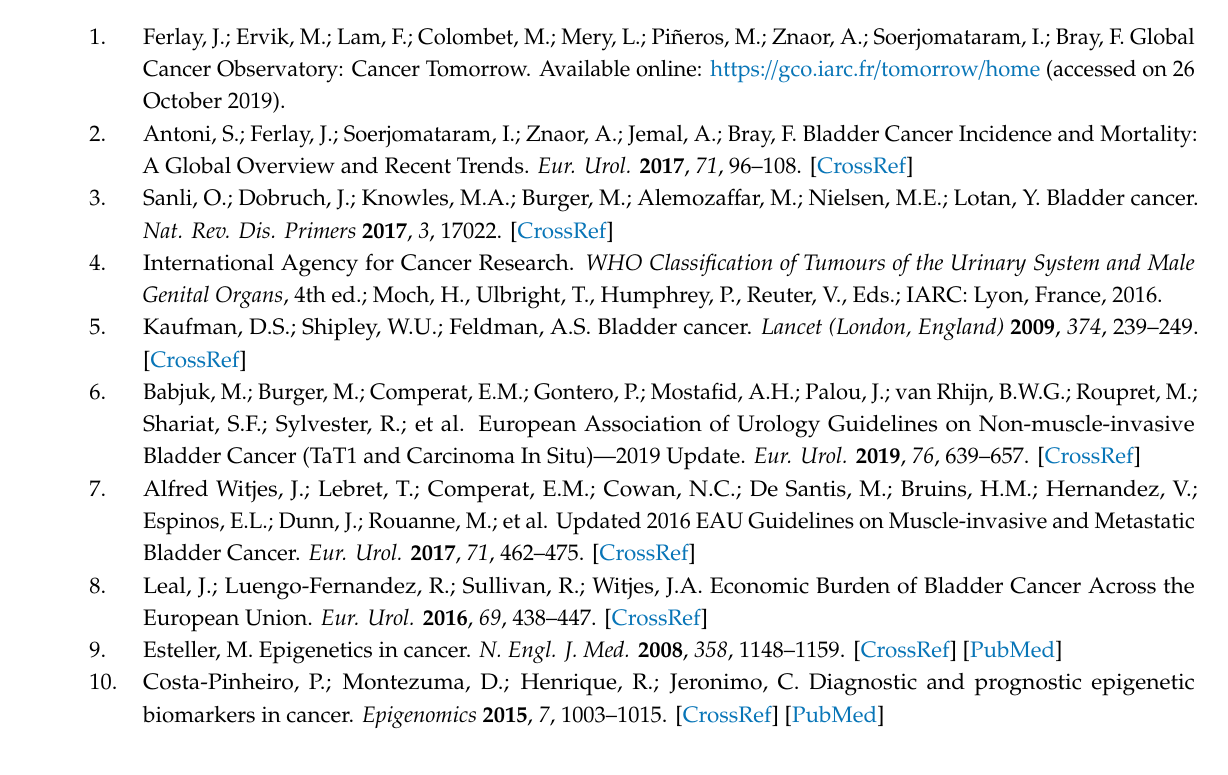
Figure S1: Distribution of miR663a me and VIM me levels in bladder carcinoma tissue samples categorised by grade; Figure S2: Kaplan-Meyer curves representing disease-specific survival according to miR663a me status; Table S1: Sequences of the primers and probes used in the quantitative methylation-specific PCR experiments; Table S2: Performance of VIM me , miR663a me and VIM me - miR663a me panel for the detection of bladder cancer in Tissues and Testing